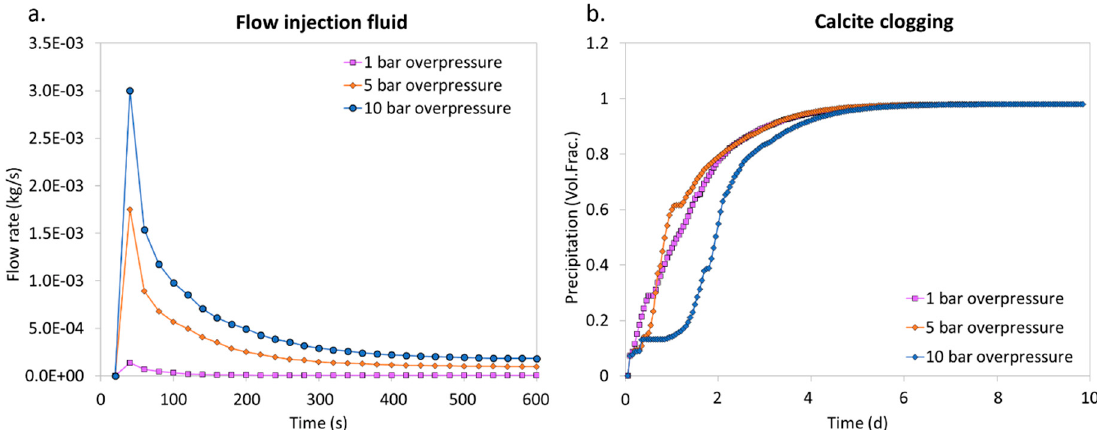
Figure 5. The development of CO 2 and water flow rate (left axis, logaritmic) and the permeability (right axis, logaritmic) in the microannulus at the level of injection of the CO 2 -reactive solution. Results are from the 5 bar overpressure scenario. Data is plotted with time for the period around leakage remediation.